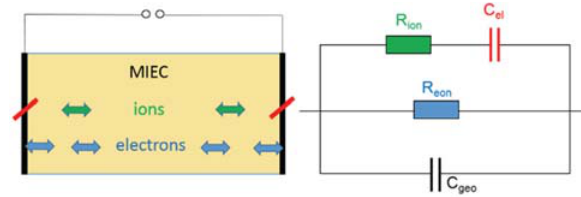
Fig. 1. Sketch of a mixed ionic and electronic conductor (MIEC) with ions blocked at the electrodes and an intuitive (but not exact) equivalent circuit describing such a situation.